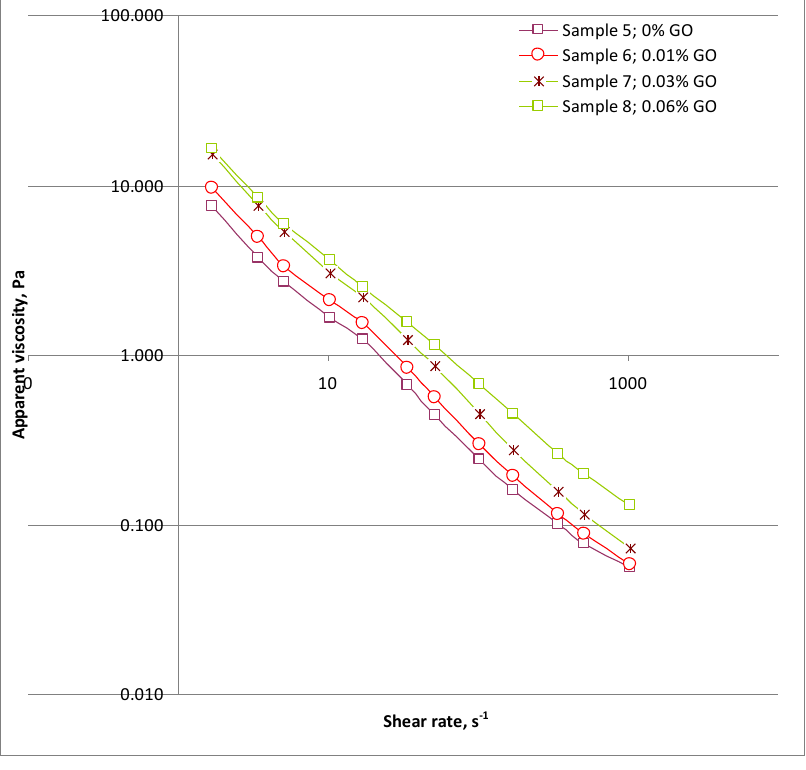
Figure 4. Graph of apparent viscosity change versus shear rate for slurries containing graphene oxide and a latex admixture.